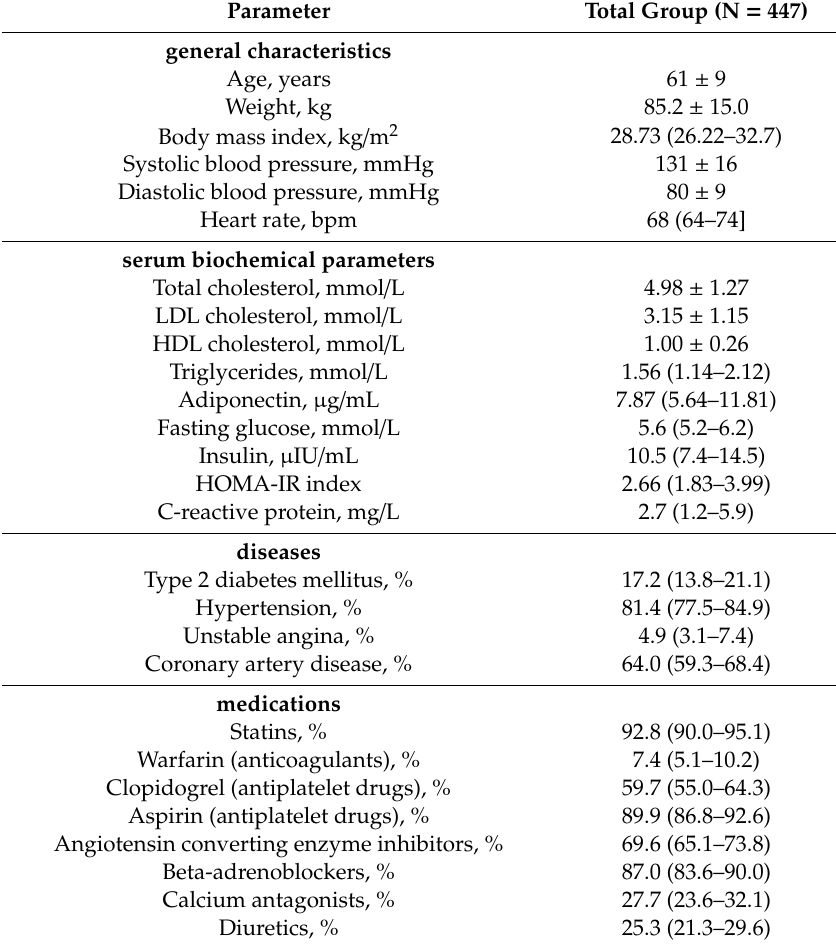
Table 2. General characteristics, biochemical tests, diseases, and medications.